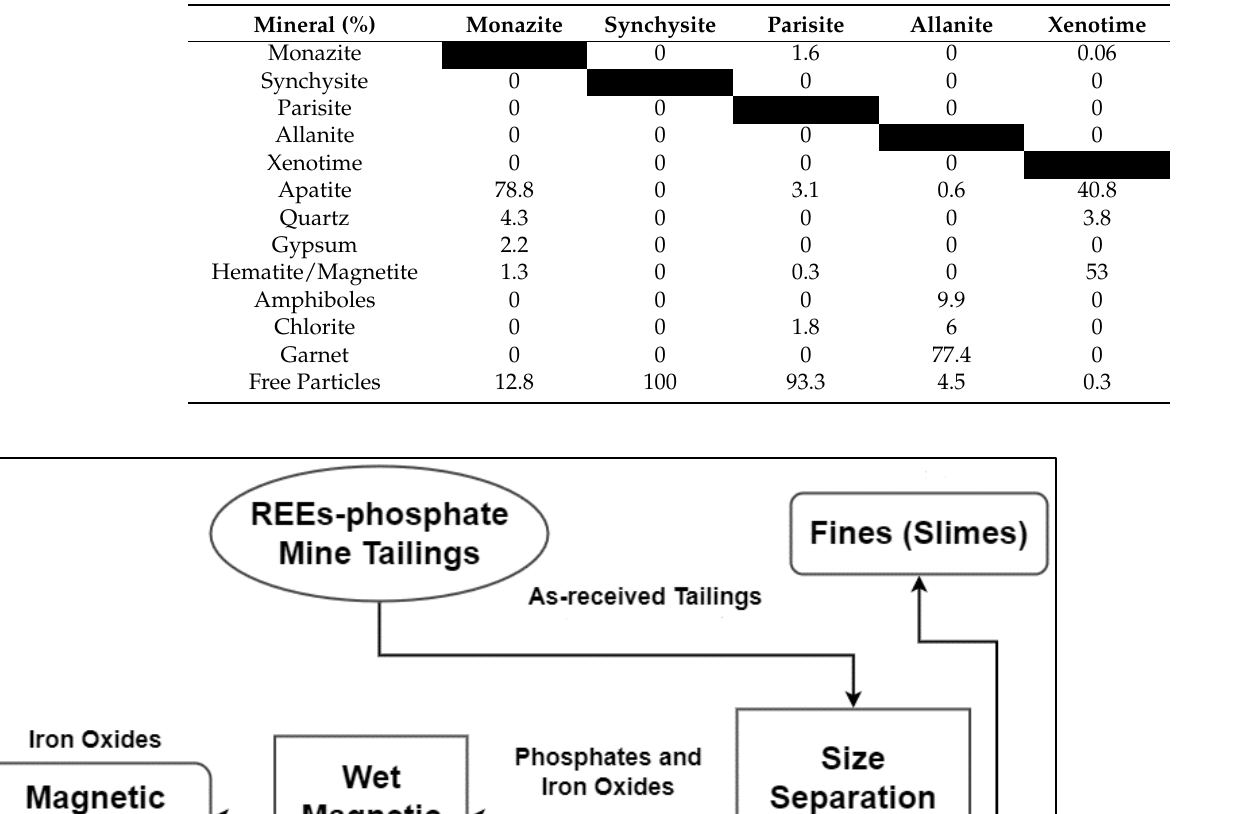
Table 6. Mineral associations of REE minerals in flotation tailings as revealed by TIMA (Chitosan was used as a depressant at 150 g/t).